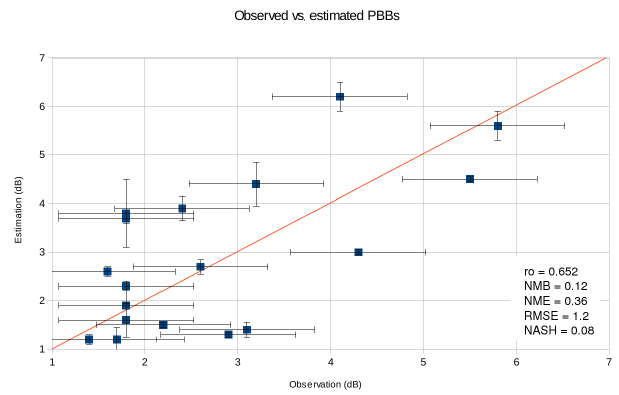
Figure 10. The scatterplot between laser-scanning-based estimated two-way losses and observed ones for Kumpula radar with 0.5 ◦ el- evation. Ro is the Pearson correlation coefficient, NMB the normal- ized mean bias, NME the normalized mean error, RMSE the root mean square error and NASH the Nash–Sutcliffe model efficiency